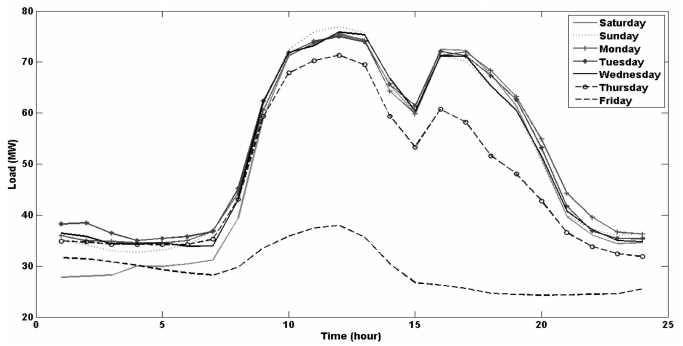
Figure 6. Hourly load curve of Shams Abad industrial zone in fall over a